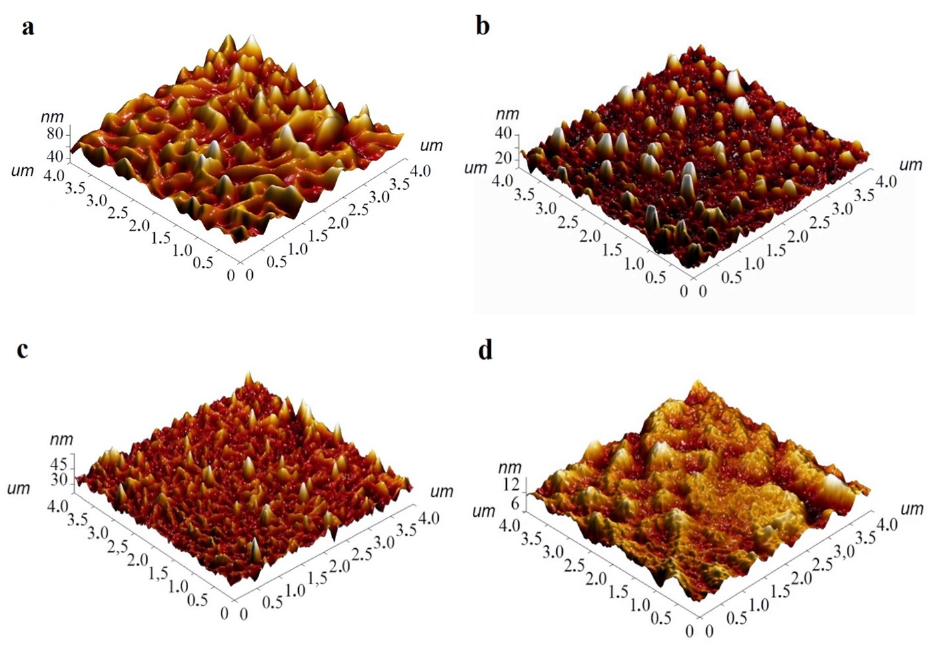
Figure 6. 3D AFM images of FePc ( a ), FePcF 4 ( b ), FePcCl 4 ( c ), and FePc(tBu) 4 ( d ) films.